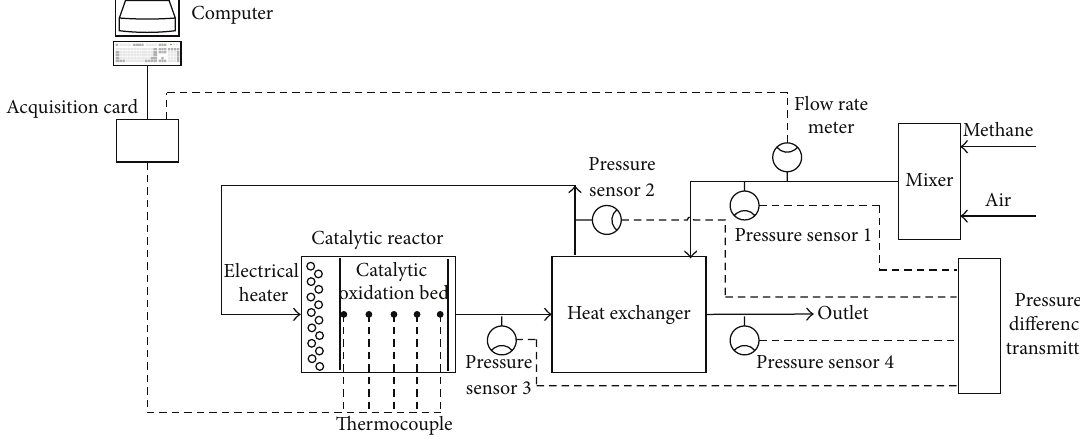
Figure 3: General overview of the research and demonstration of preheated catalytic oxidation reactor apparatus.